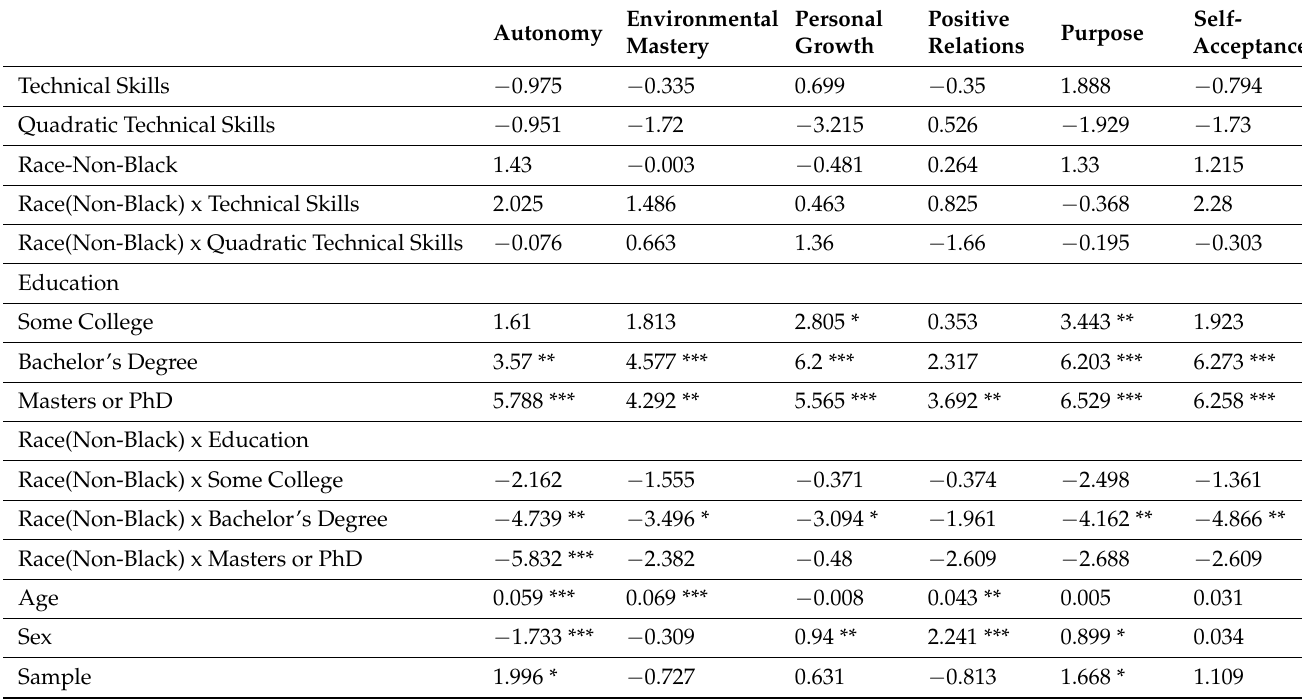
Table A5. Technical Skills and